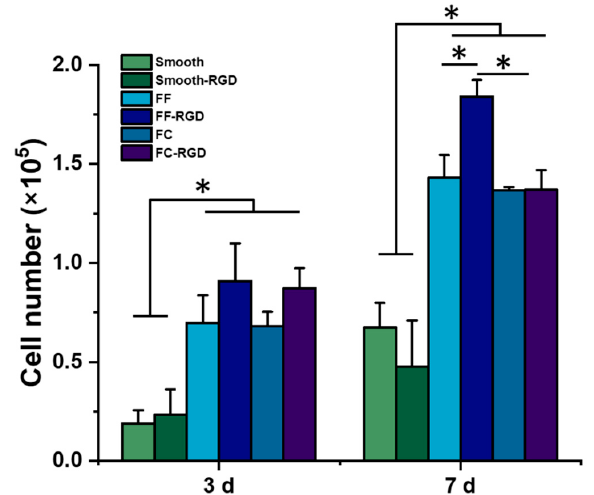
Figure 8. FF scaffolds support breast cancer cell growth. Alginate scaffolds were prepared with and without RGD peptide conjugation as smooth, FF, and FC scaffolds. The scaffolds were evaluated with MDA-MB-231 culture and cell numbers were assayed at 3 d and 7 d. (*) denotes significant difference where p < 0.05.